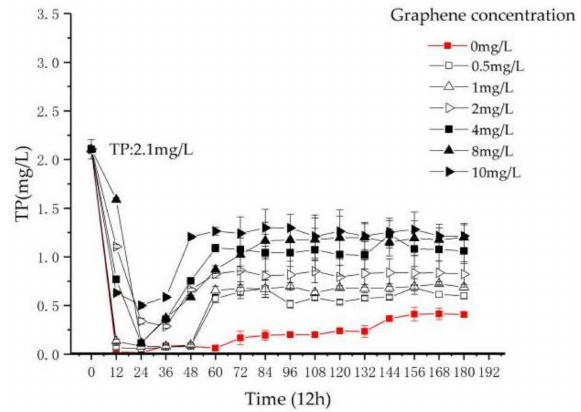
Figure 5. The variation of TP with reaction time and graphene